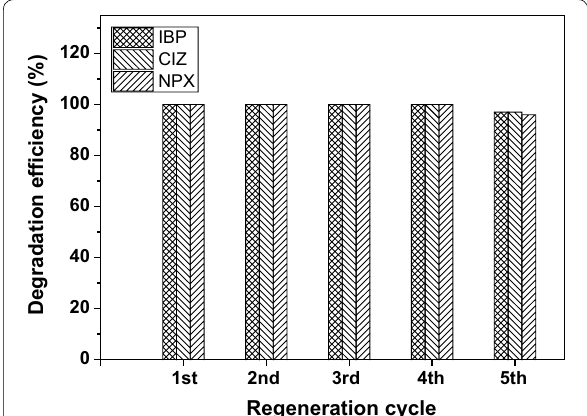
Fig. 5 Stability of the composite nanofibers for the photodegradation of IBP, CTZ, and NPX at initial concentration 5 mg/L, drug solution volume of 100 mL, irradiation time of IBP 120 min, NPX 40 min, and CIZ 25 = = =